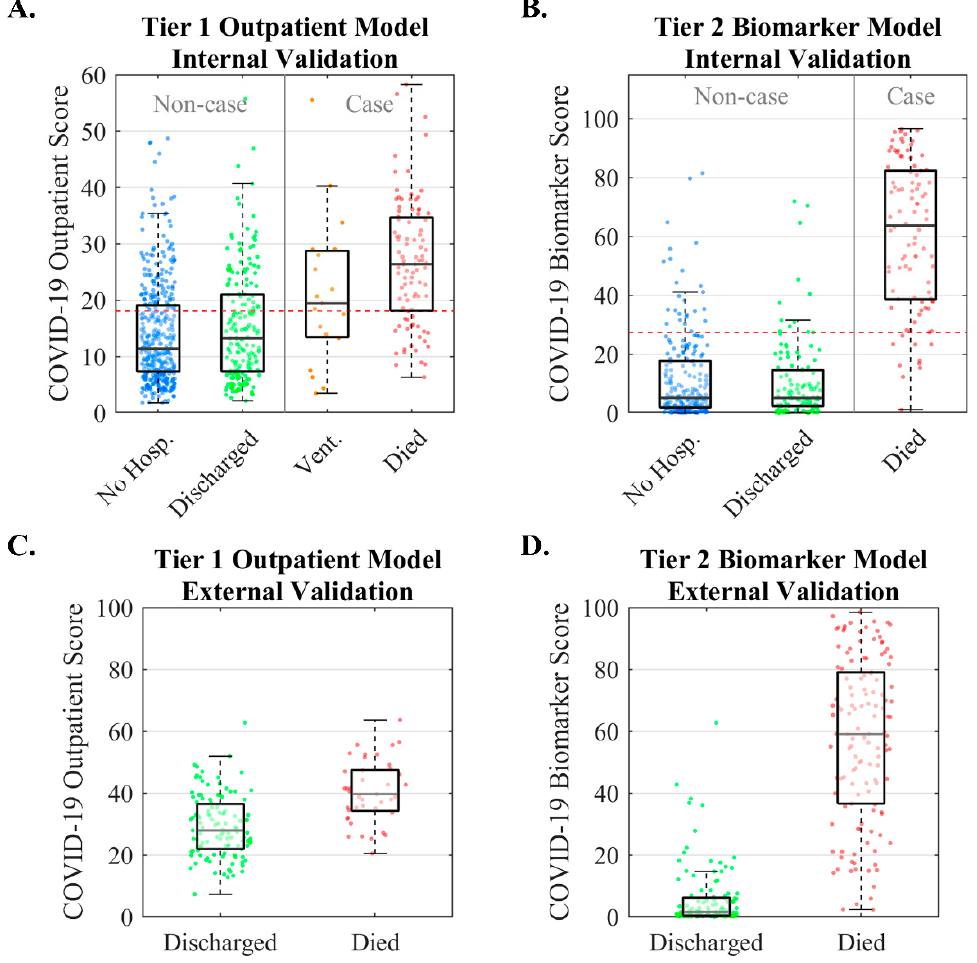
Figure 4. Internal and external validation results for the two-tiered COVID-19 disease severity models. The Tier 1 Outpatient Model is the probability of severe COVID-19 complications (ventilation or death) based on age, gender, systolic blood pressure, cardiovascular comorbidities, and diabetes status. The Tier 2 Biomarker Score is the probability of mortality from COVID-19 based on age, D-dimer, PCT, and CRP. Internal validation of the Tier 1 Outpatient Model ( A ) and Tier 2 Biomarker Model ( B ). External validation for Tier 1 Outpatient Model ( C ) and Tier 2 Biomarker Model ( D ). (No Hosp. = patients who were not hospitalized, Vent. = patients who were ventilated). Reproduced